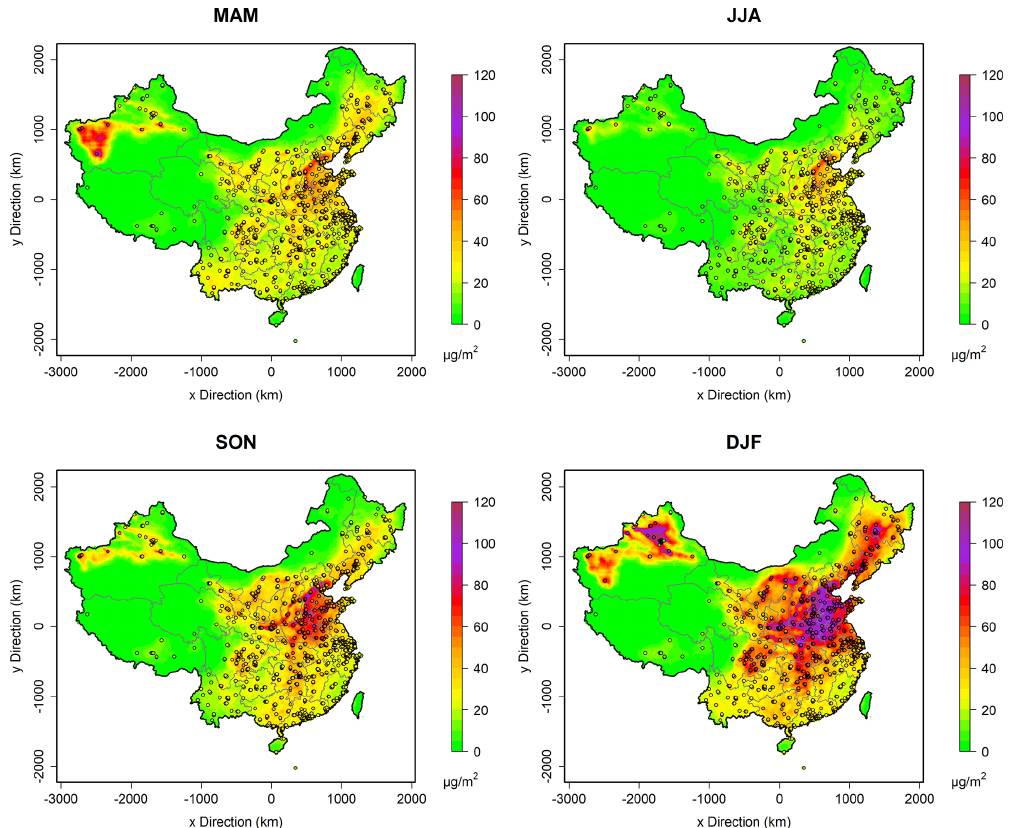
Figure 7. Reanalysis PM 2 . 5 concentration fields in four seasons in 2020. Circles with filled colors represent monitoring sites and correspond- ing